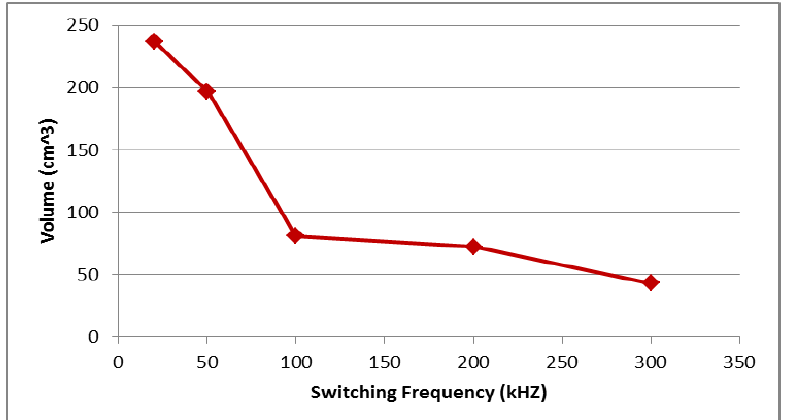
Figure 13. The effect of increasing the switching frequency on magnetic core volume.